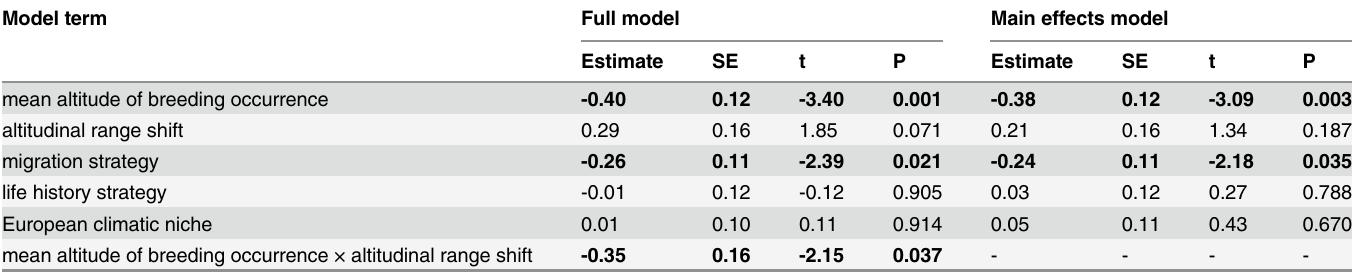
Table 1. Relationships between long-term population trends of birds breeding in the Giant Mountains (Czech Republic), estimated for the time period 1984 – 2011, and particular species ’ traits as revealed by linear models. Model